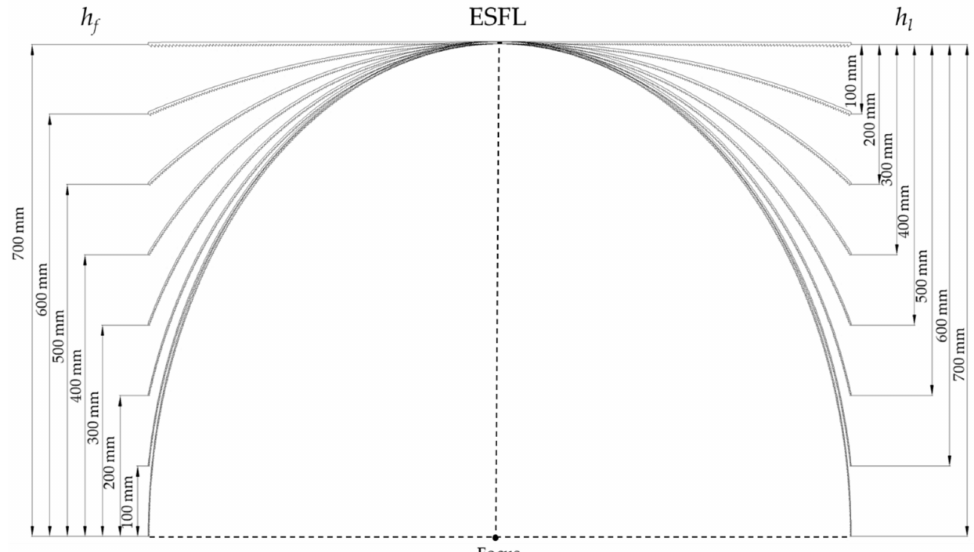
Figure 12. ESFL configuration with a combination of h f and h d for a total height of 700 mm.